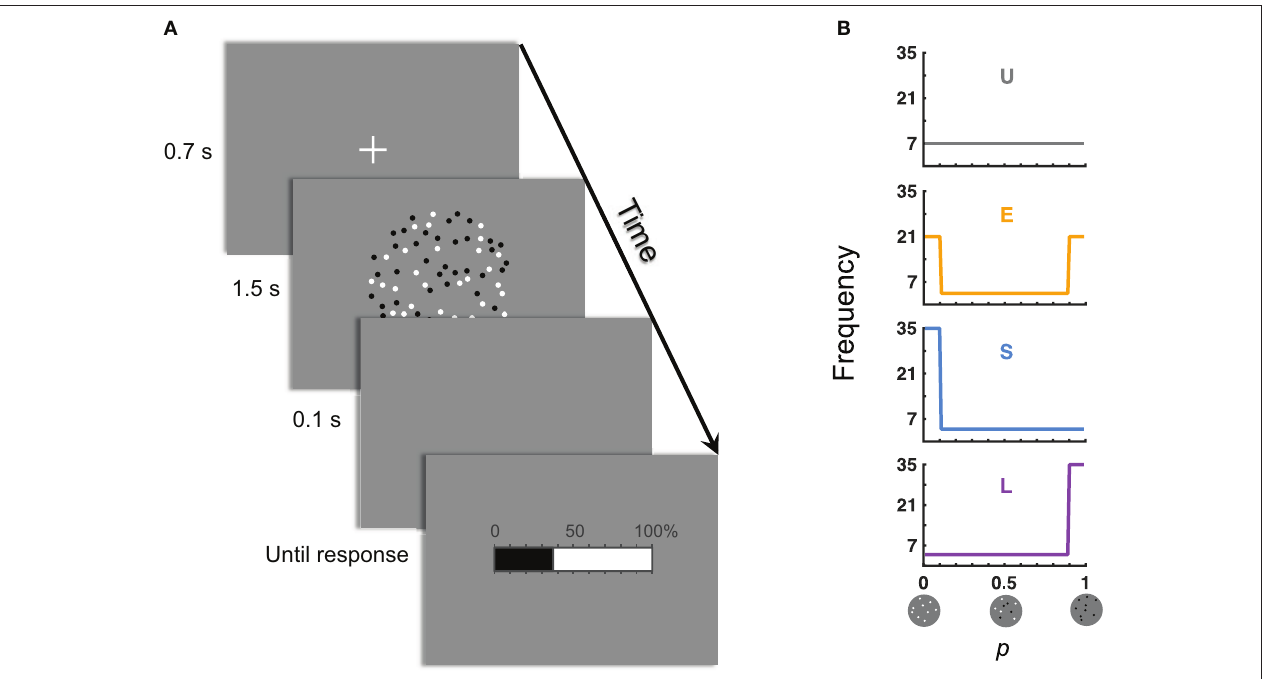
FIGURE 1 | The experiment: judgment of relative-frequency. (A) Time course of a trial. The task was to judge the relative-frequency of the black (or white) dots in the array of black and white dots and to report the judgment on the 0–100% scale. (B) Distributions of the objective relative-frequencies in the four experimental conditions . The values of the objective relative-frequencies (denoted p ) could be 0.01, 0.02, … , 0.99. Those in the ranges of [0.01, 0.10] and [0.90, 0.99] were referred, respectively, as the small and large p ’s. “U” denotes the condition with a Uniform distribution of p . “E” denotes the condition where the Extreme (small